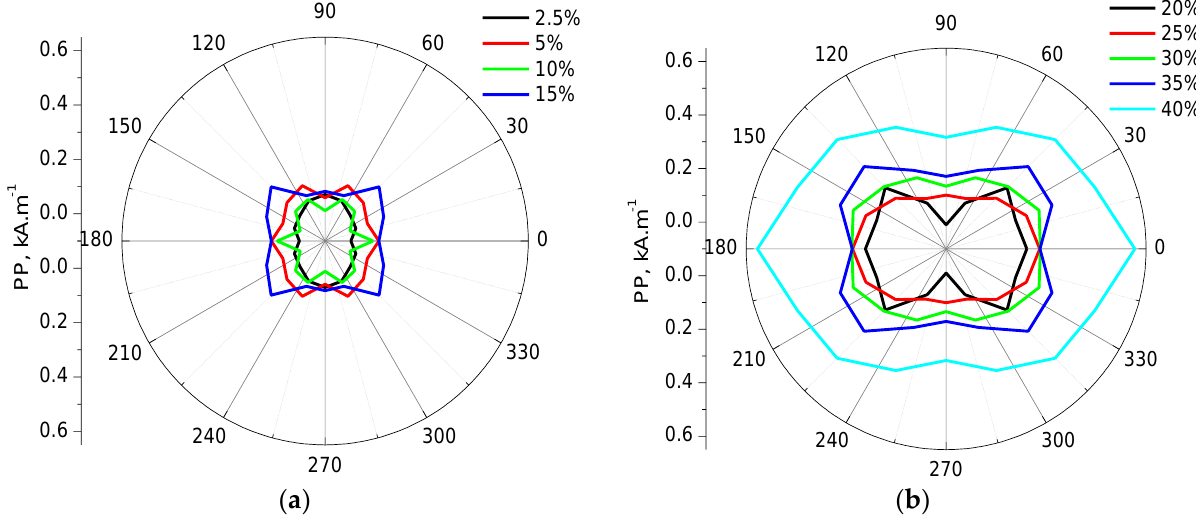
Figure 9. Angular dependence of Peak Position ( PP ) as a function of ε . ( a ) ε = 2.5 ÷ 15%, ( b ) ε = 20 ÷ 40%; 0° corresponds